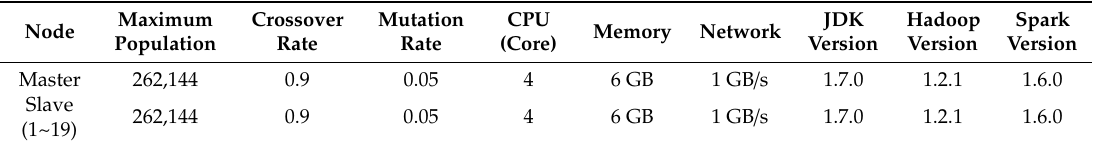
Table 1. Configuration of the